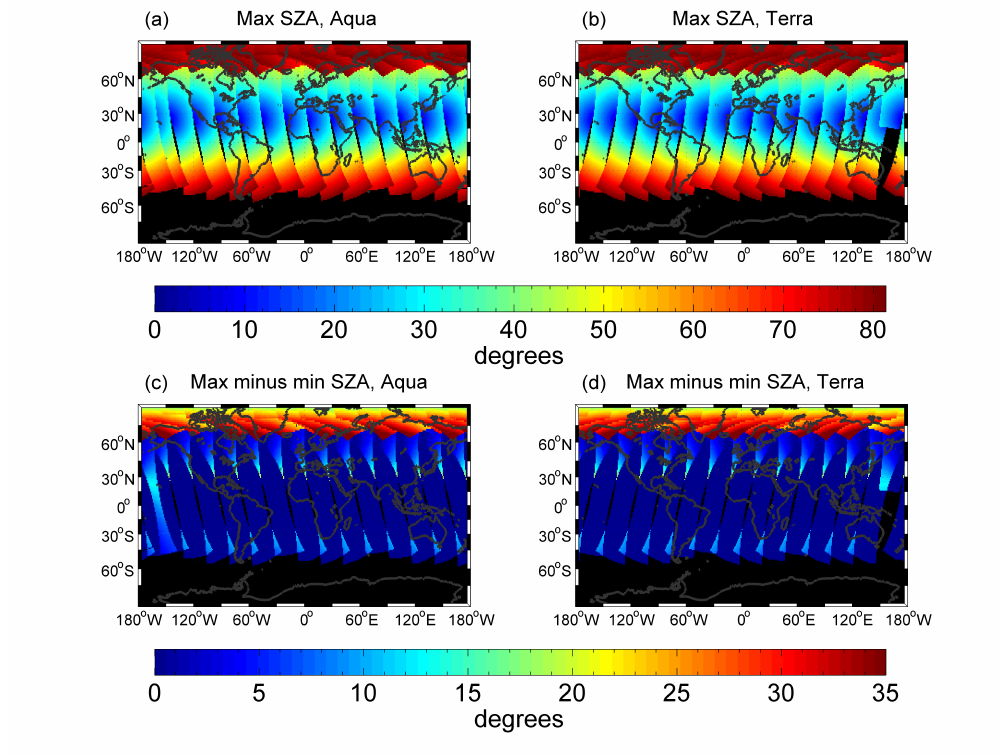
Figure 1. Solar zenith angle (SZA, or θ 0 ) properties for a single day (20 June 2007; approximately the solstice) of maximum θ 0 ( a and b ) and maximum minus minimum θ 0 ( c and d ) for daytime (SZA ≤ 81 . 4 ◦ ) data. ( a and c ) MODIS Aqua, ( b and d ) MODIS